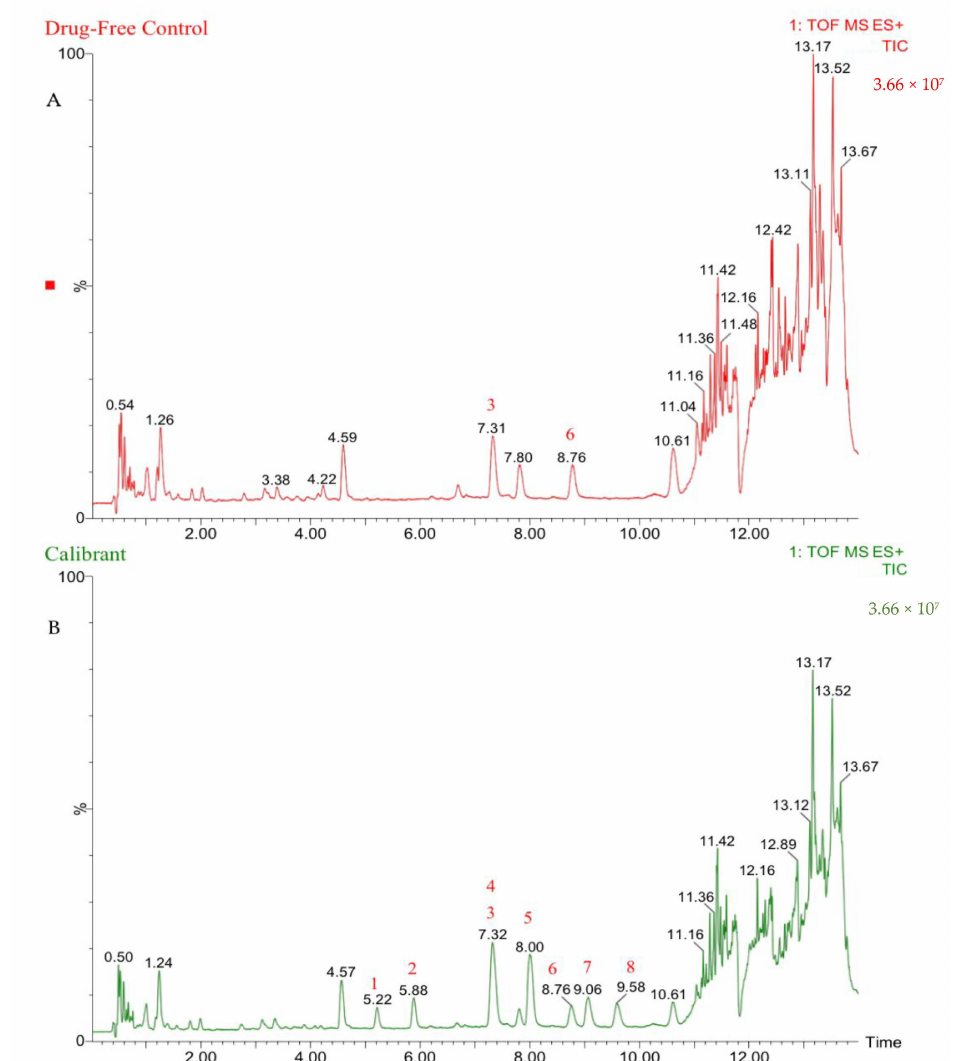
Figure 4. Total ion chromatogram of extracted aged animal whole blood; ( A ) drug-free control and ( B ) spiked with 800 ng/mL of the combined working solution and 500 ng/mL of the internal standard solution: (1) norephedrine, (2) cathine, (3) ephedrine-d3, (4) ephedrine, (5) pseudoephedrine, (6) amphetamine-d11, (7) amphetamine, and (8) β